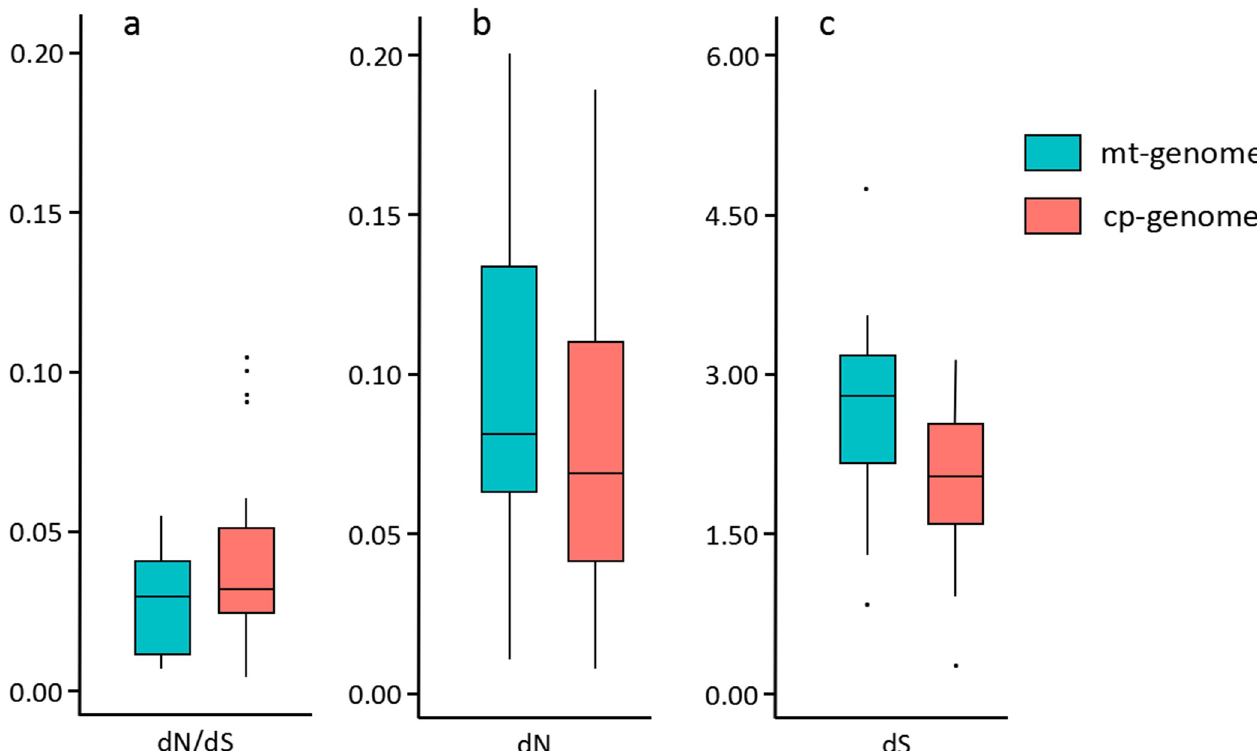
Fig 4. Boxplots showing synonymous substitutions (dS), nonsynonymous substitutions (dN), and dN/dS ratios in mt- and cp-genomes in Phaeophyceae. The box represents the values between the quartiles. Outliers are shown as black points, and the black lines inside the box represent the median